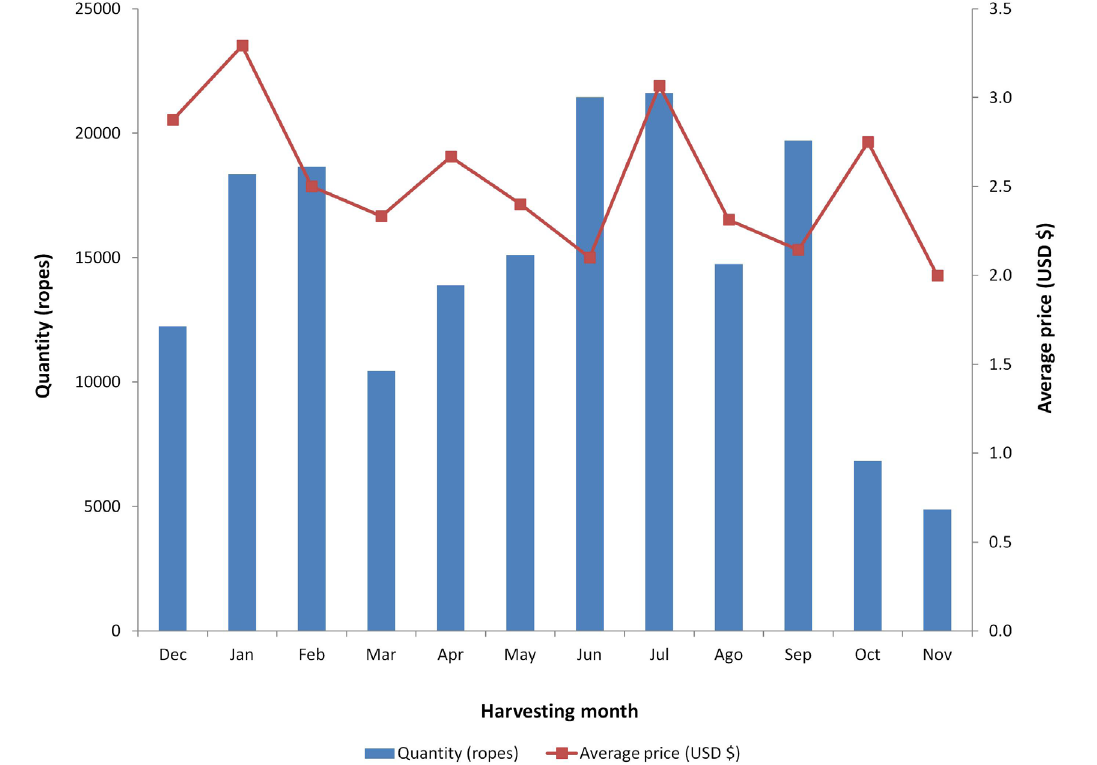
Figure 8. Price of ropes (USD $) of Ucides cordatus marketed during daytime landing at Tatus Harbor, Ilha Grande, Piauí, Brazil, from December 2014 to November 2015.